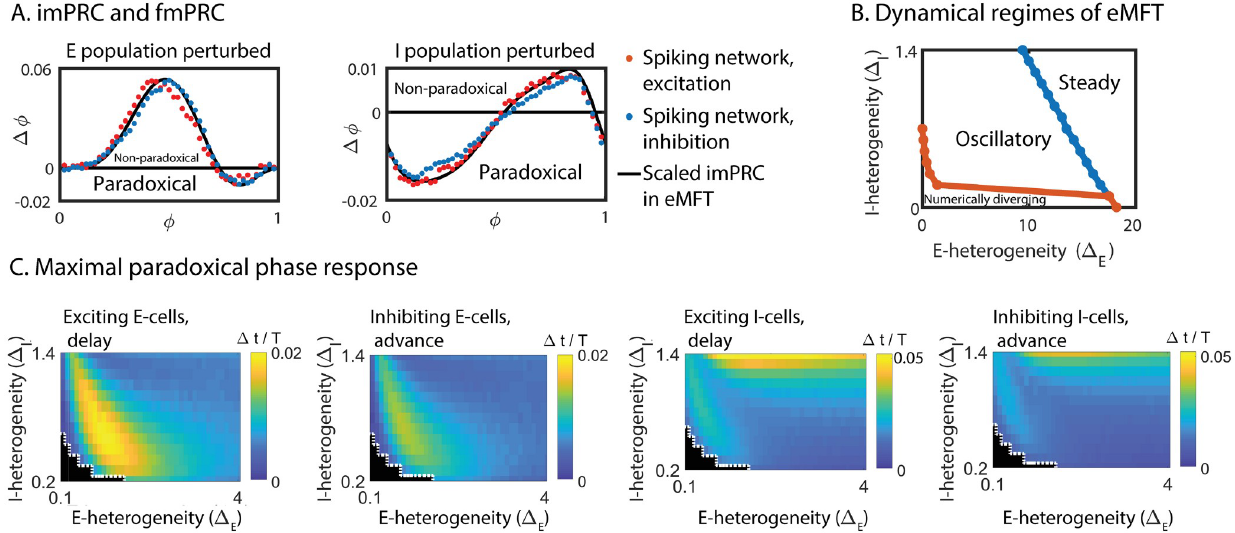
Fig 9. PING rhythms in heterogeneous QIF networks and their eMFT-reduction. (A) The imPRC (black line) of the eMFT multiplied by the signed perturbation strength agreed well with the fmPRCs (orange = excitation, blue = inhibition) from the spiking network simulations when perturbing the E- population (left) or the I-population (right). The negative component corresponds to a paradoxical phase response, either a delay for excitation (orange) or an advance for inhibition (blue). (B) Dynamical regimes of the PING rhythm in the eMFT. (C) The maximal paradoxical phase response obtained from simulations of the eMFT. Paradoxical phase response always existed. The black regions below the white dashed line correspond to the area below the orange line in (B). Parameters: voltage perturbations Δ V E , I were made to the membrane potential or the mean potential variable V E , I ( t ) with a square-wave pulse of duration 0.02 ms. In (A), Δ V = ± 0.2, Δ = 1, Δ = 1. In (C), Δ V = ± 0.2. E , I E I E , I